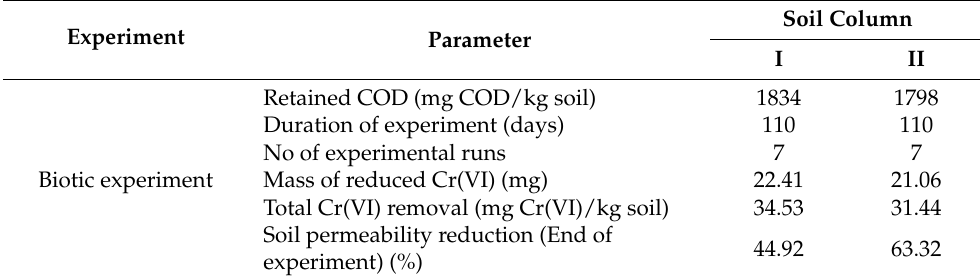
Table 5. Experimental results from the biotic